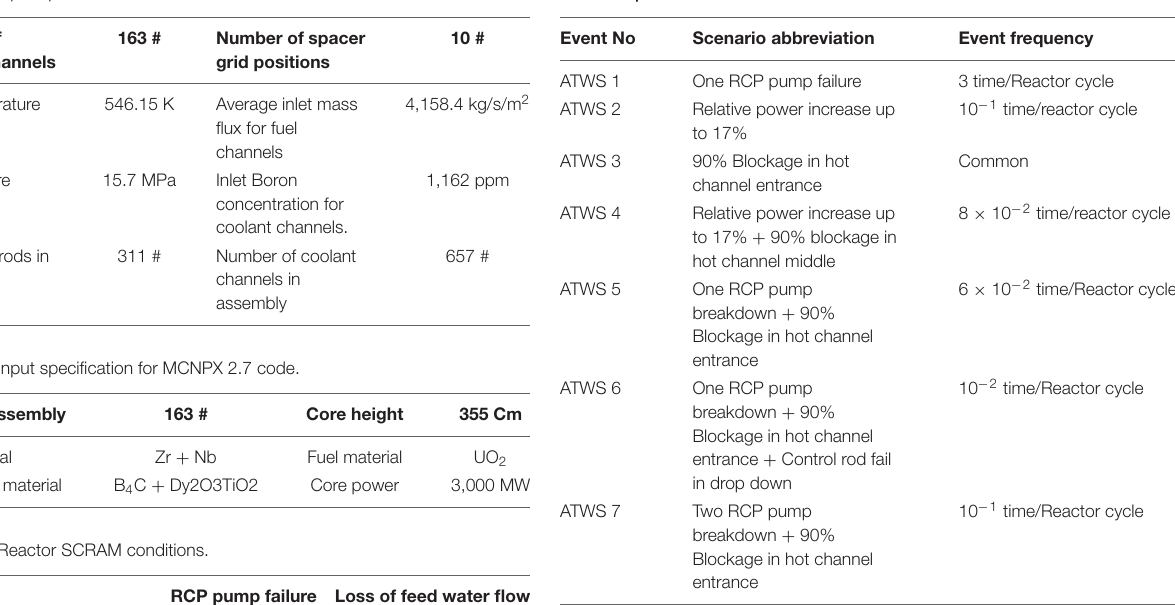
TABLE 1 | Input specifications for COBRA-EN code.